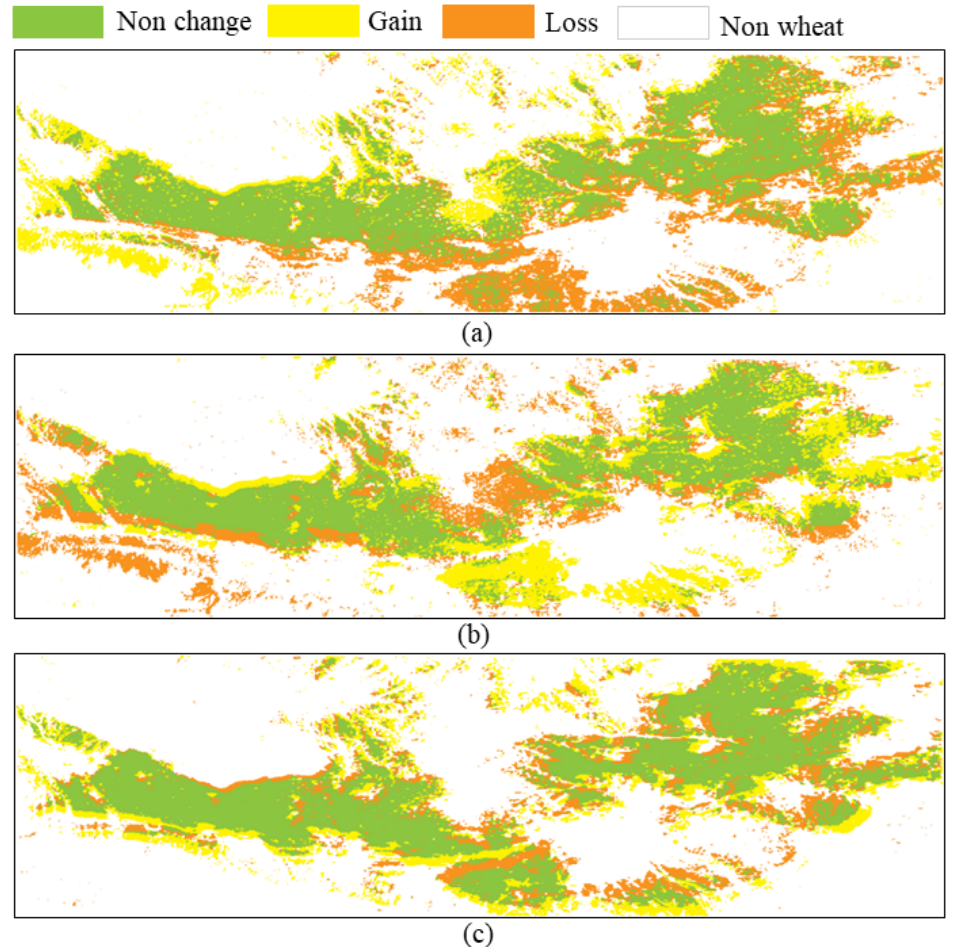
Figure 13. Distribution and change of winter wheat in the study area from 2011 to 2014. ( a ) Wheat distribution change map from 2011 to 2012. ( b ) Wheat distribution change map from 2012 to 2013. ( c ) Wheat distribution change map from 2013 to